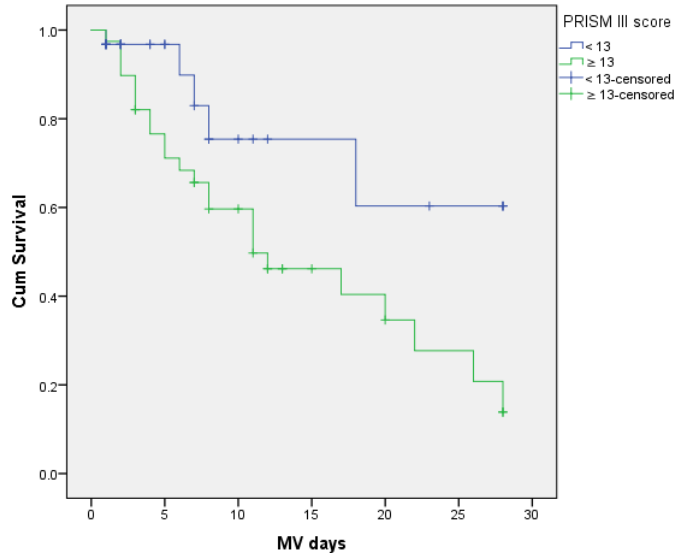
Figure 2. Kaplan–Meier survival curves for PRISM III score values which are < 13 and > 13 for prediction on short-term mortality in PARDS. Notes: Log Rank Mantel-Cox test: χ 2 = 4.820; p = 0.028, Median: PRISM III < 13 = 28 days (Estimation is limited to the largest survival time if it is censored);